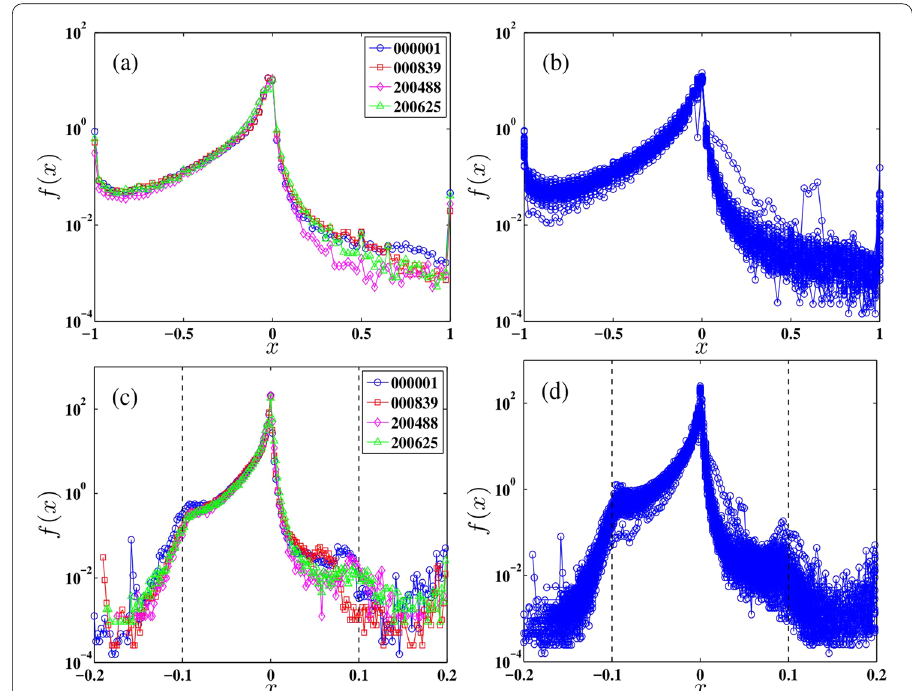
Fig. 2 Empirical probability density function f ( x ) of relative prices. a , c Two A‑share stocks 000001 and 000839 and two B‑share stocks 200488 and 200625. b , d All the 43 stocks. The relative prices are defined according to price limits in plots ( a ) and ( b ) and according to Mike and Farmer (2008) in plots ( c ) and ( d )